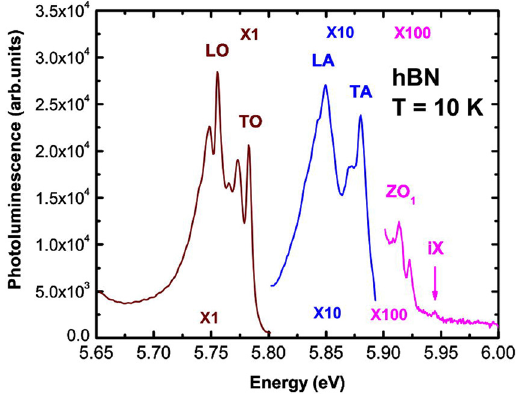
Figure 12: Zoom of the 8 K PL in the 5.65 – 6.0 eV region to evidence: